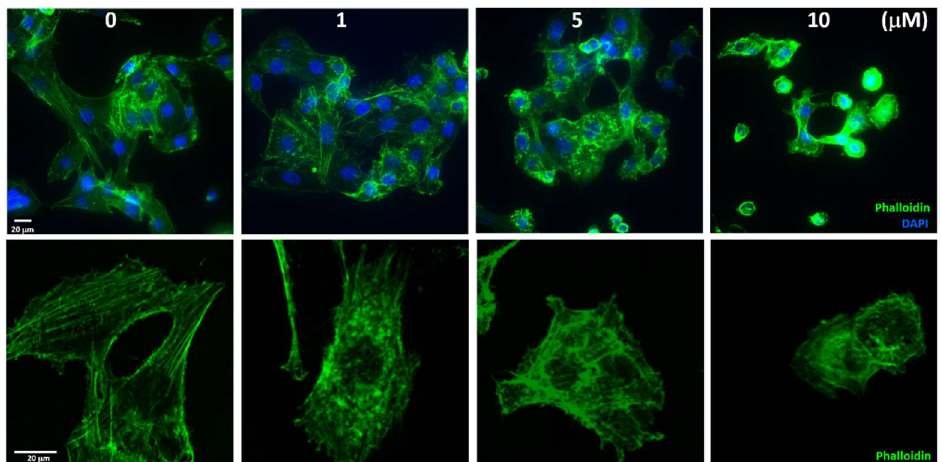
Figure 5. Sinularin effect F-actin expression in SK-Hep-1 cells. Immunofluorescence staining was used to evaluate the distribution of the F-actin filaments. The cells were pretreated with increasing concentrations of sinularin for 24 h and then stained with Alexa Fluor 488 Phalloidin (the F-actin filaments are shown in green) and DAPI (the nuclei position is shown in blue). The immunofluorescence profiles were visualized using a fluorescence microscope (upper, 400× magnification) and a confocal fluorescence microscope (lower, 1000× magnification).